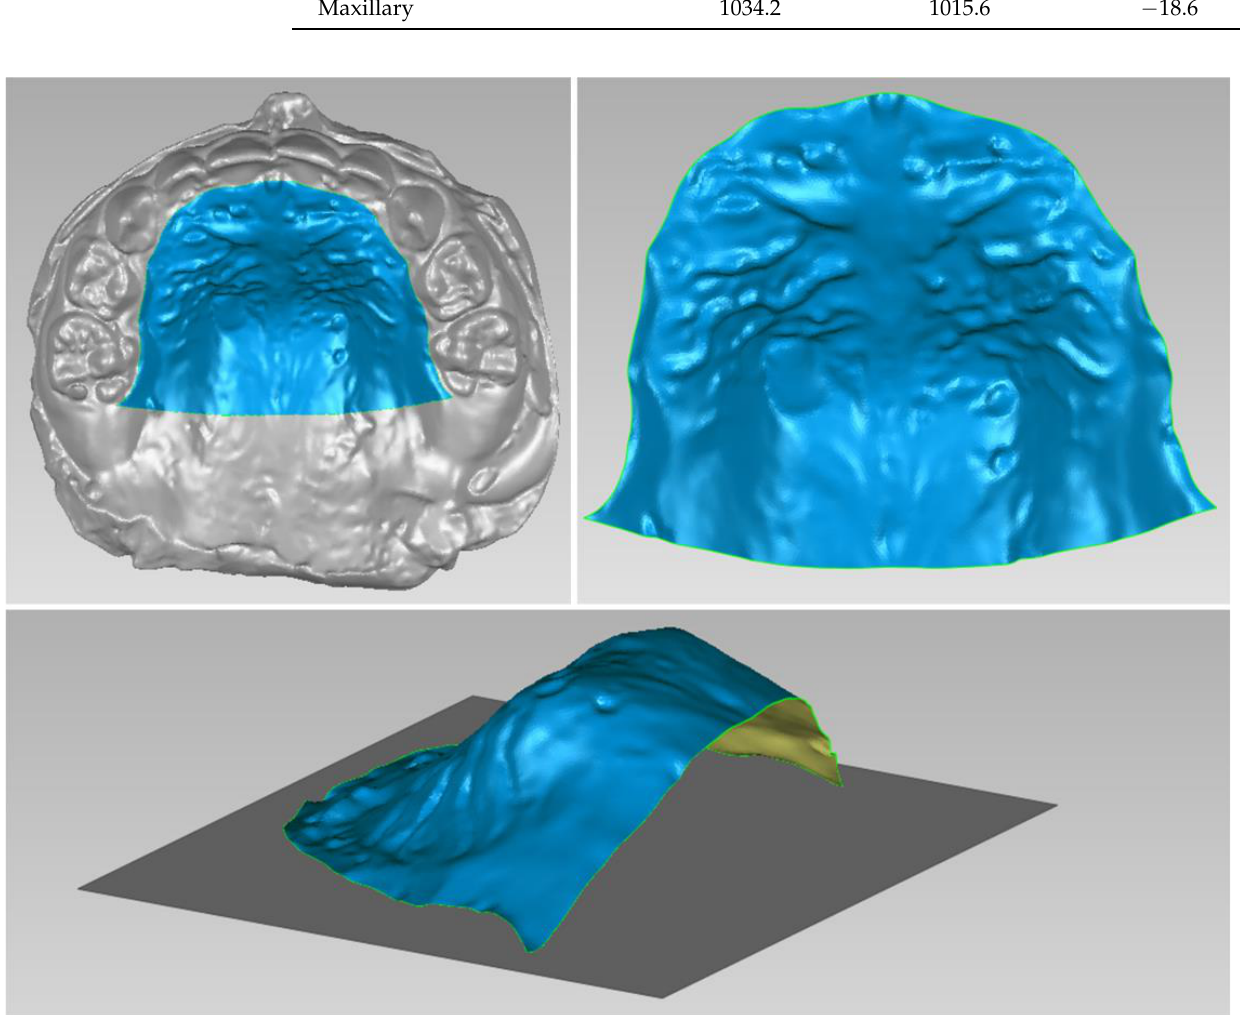
Figure 6. Digital cast measurement of the initial cast.